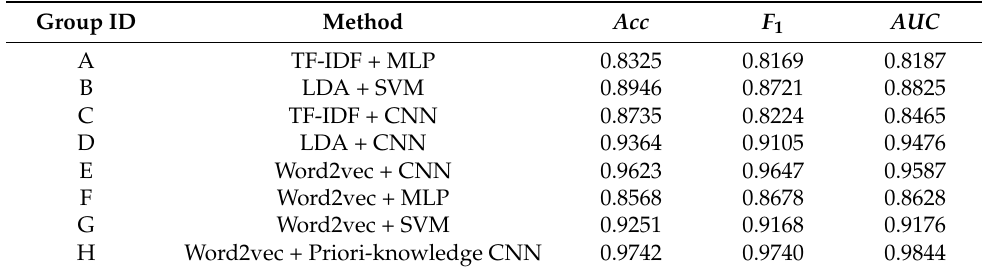
Table 5. Comparison table of the classifier evaluation